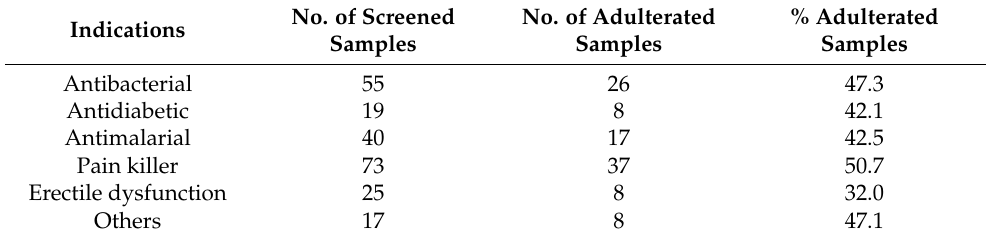
Table 5. Adulterated herbal products according to therapeutic